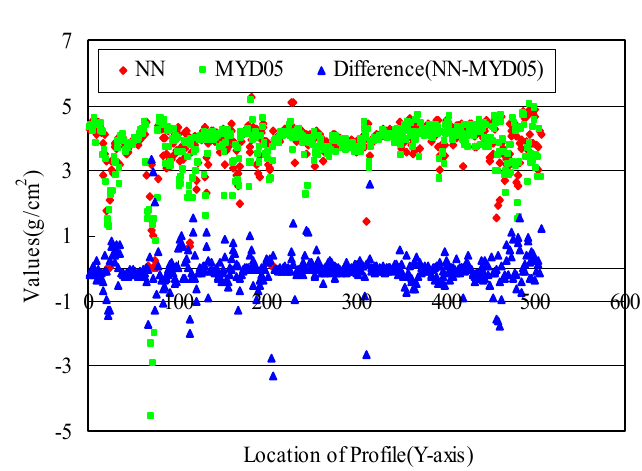
Figure 13. The Y -axis profile in Figures 9–11.